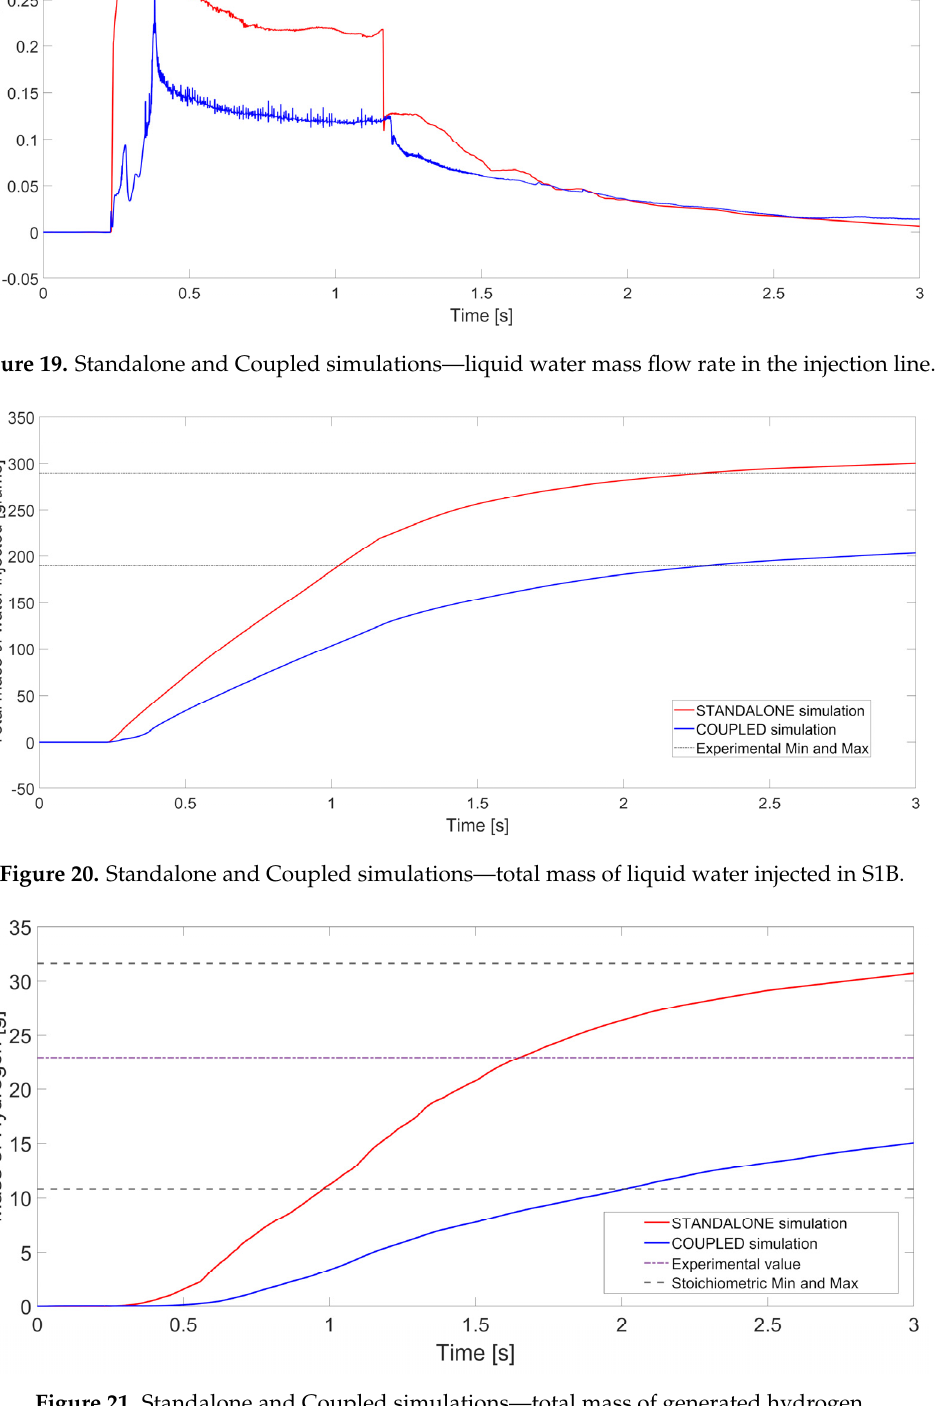
Figure 21. Standalone and Coupled simulations—total mass of generated hydrogen.